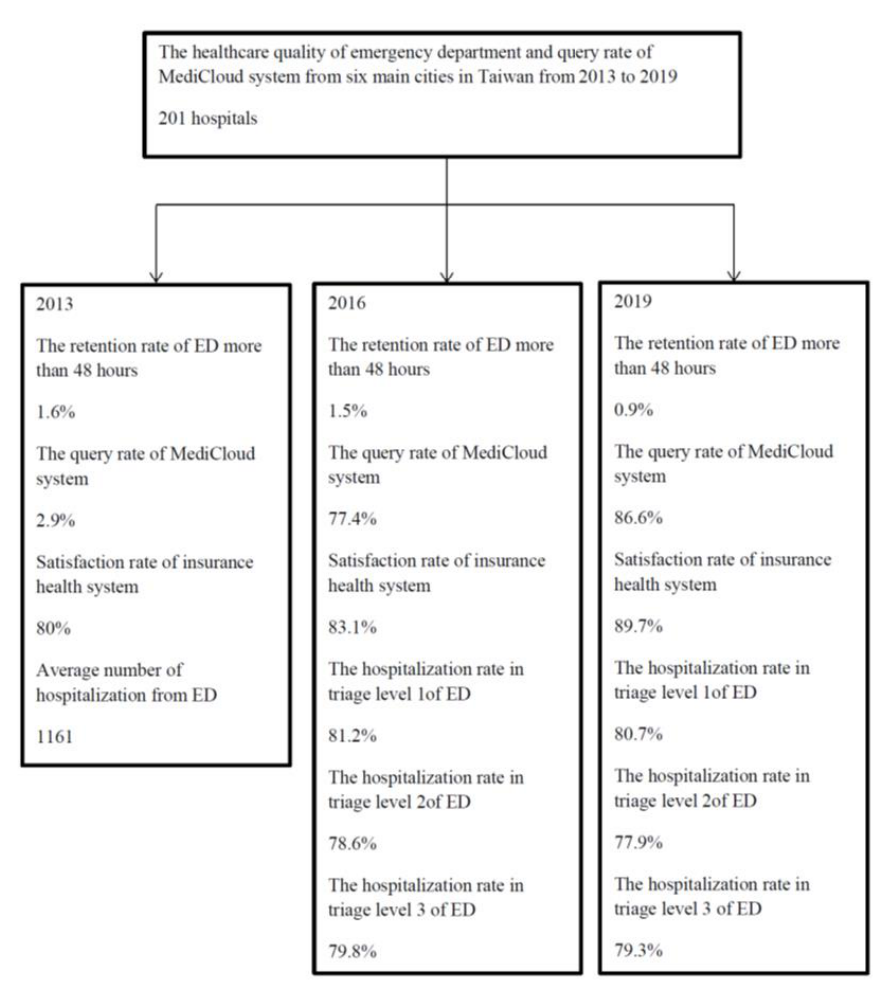
Figure 1. The flowchart of this study.